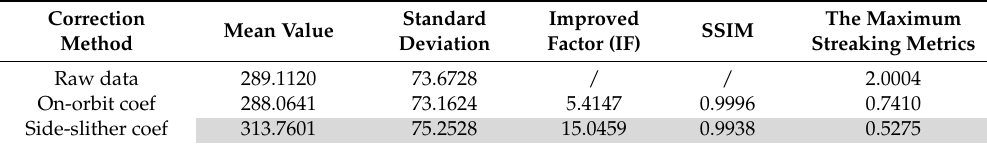
Table 4. Comparison of quantitative values of the city